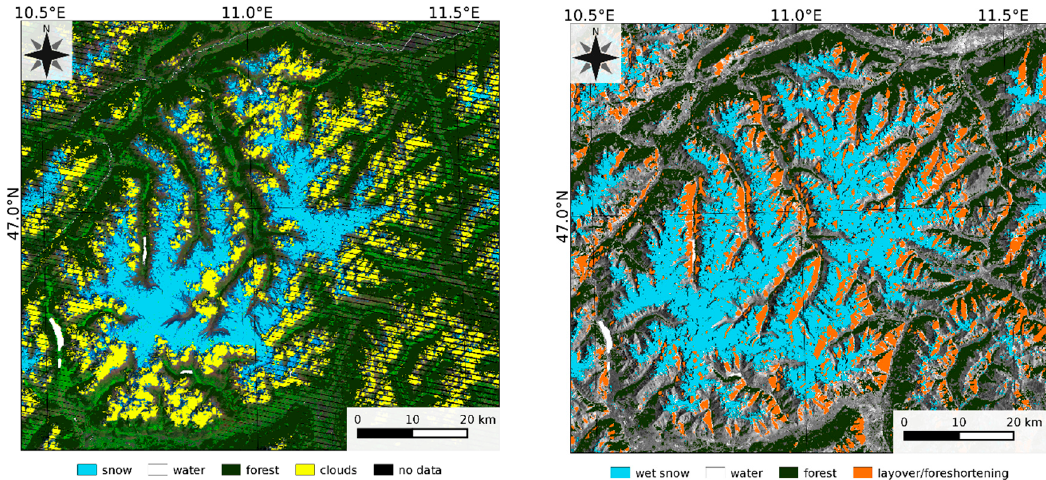
Figure 4. Snow map of the Ötztal mountain region, Eastern Alps of Austria and Italy. ( Left ) Snow extent (blue) derived from Landsat-7 image of 5 June 2015; yellow: clouds; white: water; background: Landsat-7 ETM+ bands 5, 4, 3. ( Right ) Wet snow extent (blue) derived from Sentinel-1 image of 2 June 2015; background: S1 amplitude image, VV -channel; orange: mask for layover and foreshortening.